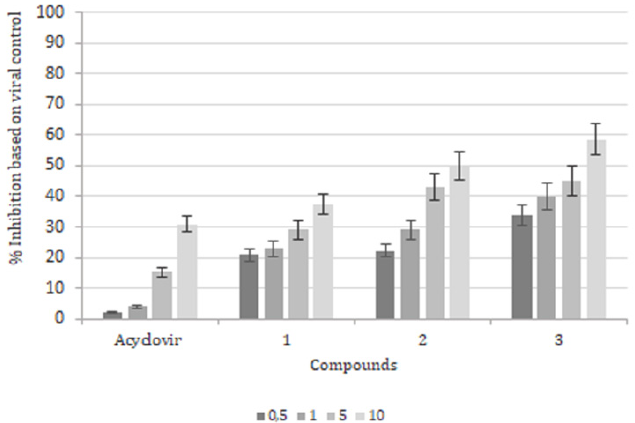
Figure 3. Attachment assay. Vero cells (3 × 10 5 cells/well) were incubated for 2 hours with HSV (MOI = 0.1) at 4 °C in the presence or absence of 2-aminomethyl-3-hydroxy-1,4 naphthoquinones encapsulated into liposomes. The level of infection was determined 48 h later by plaque-forming unit counts. The results were expressed as Mean ± SD of three independent experiments. P < 0.05